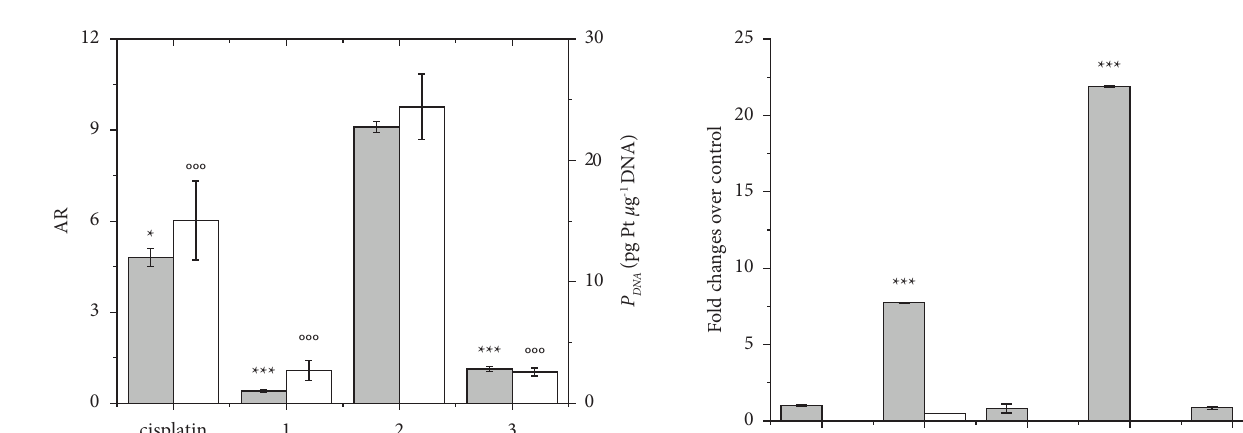
Figure 3: AR (gray bars, left axis scale) and DNA platination ( P Figure 4: Te caspase 3/7 activity assay. A2780 cells were treated DNA in pg Pt μ g − 1 DNA, white bars, right axis scale) of cisplatin and with cisplatin and 1 – 3 at equimolar concentrations (10 μ M) for 24h Complexes 1 – 3 in A2780 cells after 24h CTat 10 μ M concentration. CT. Te Ac-DEVD-AFC fuorogenic substrate of caspase 3/7 was Data are the mean ± sd of three independent replicates and were added to treated cells to highlight caspase activity (gray bars). compared using one-way analysis of variance (ANOVA) with the Parallelly, the Ac-DEVD-CHO inhibitor was also added to a second Tukey post-hoc test. Statistical analysis (AR, cisplatin, 1 , and 3 vs. set of treated cells to verify the specifc activity (white bars, visible 2 ): ∗ p < 0.05, ∗∗∗ p < 0.001; ( P , cisplatin, 1 , and 3 vs. 2 ): °°° p DNA only for cisplatin). Data are the mean ± SD of three independent < replicates and were compared using one-way analysis of variance (ANOVA) with the Tukey post-hoc test. Statistical analysis (cis- platin, 1 – 3 vs. NT): no indication � not signifcant, ∗∗∗ p < 0.001.